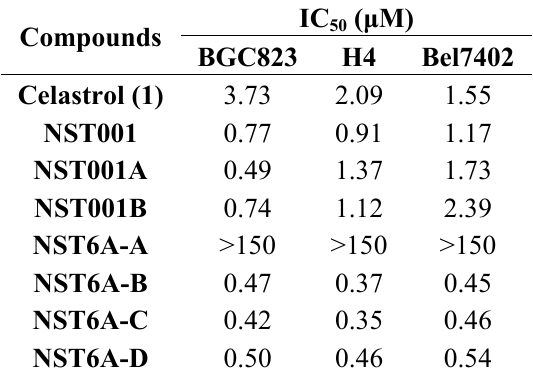
values ( μ M) on human cancer cell Table 1. IC 50